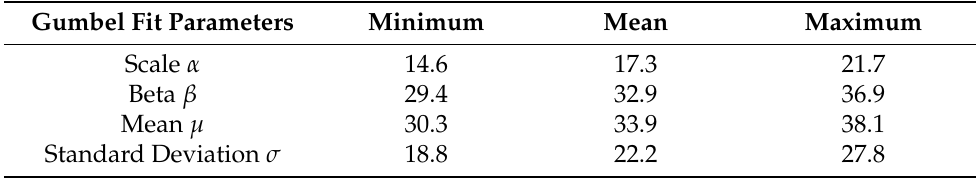
Table 3. Summary of minimum, mean, and maximum Gumbel fit parameters.